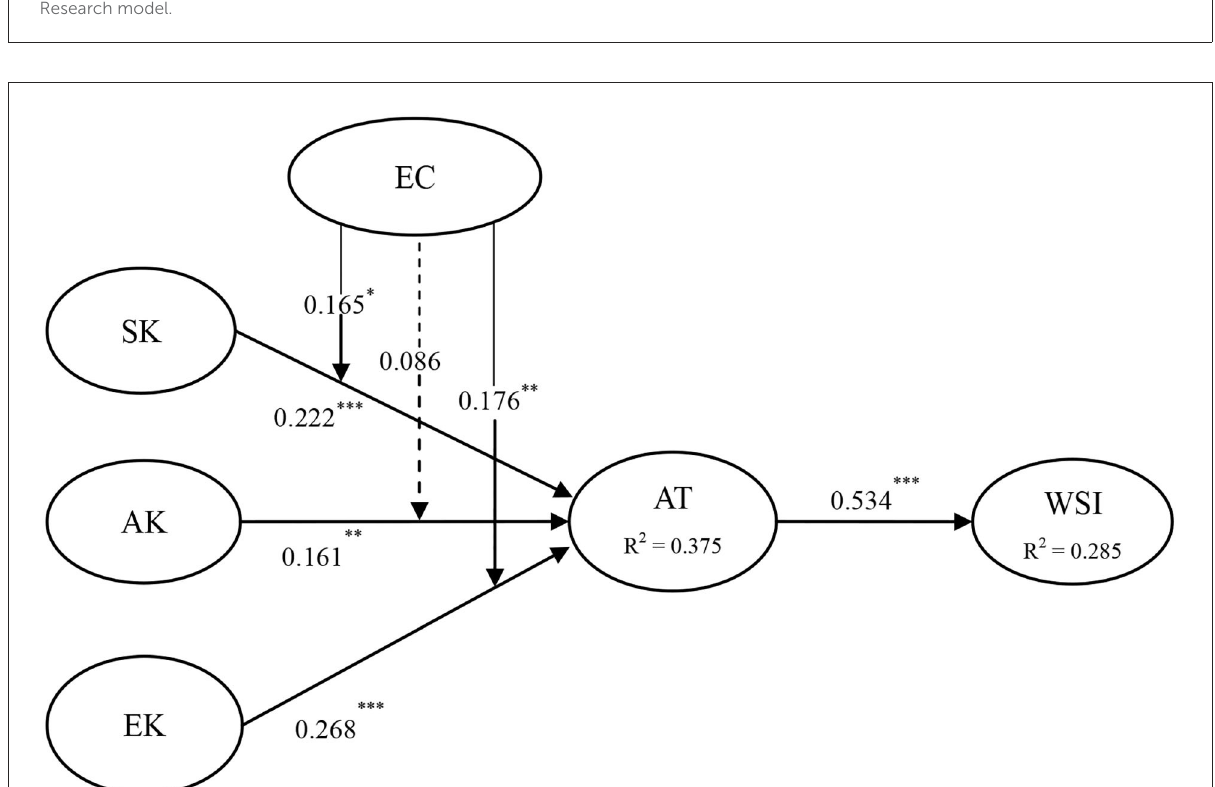
on the corresponding structure and average variance extraction (AVE) of the structure (Fornell and Larcker, 1981). Table